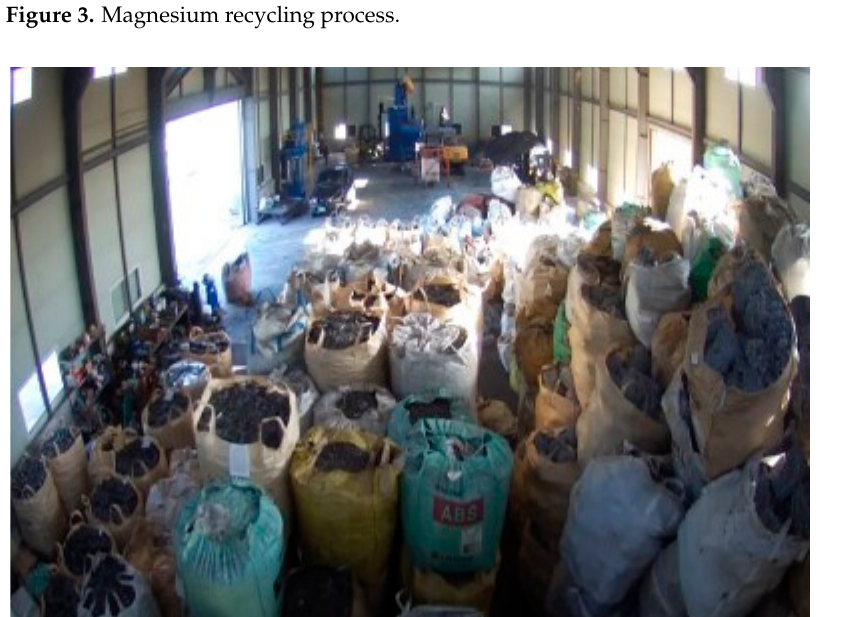
Figure 4. Scrapped magnesium products.